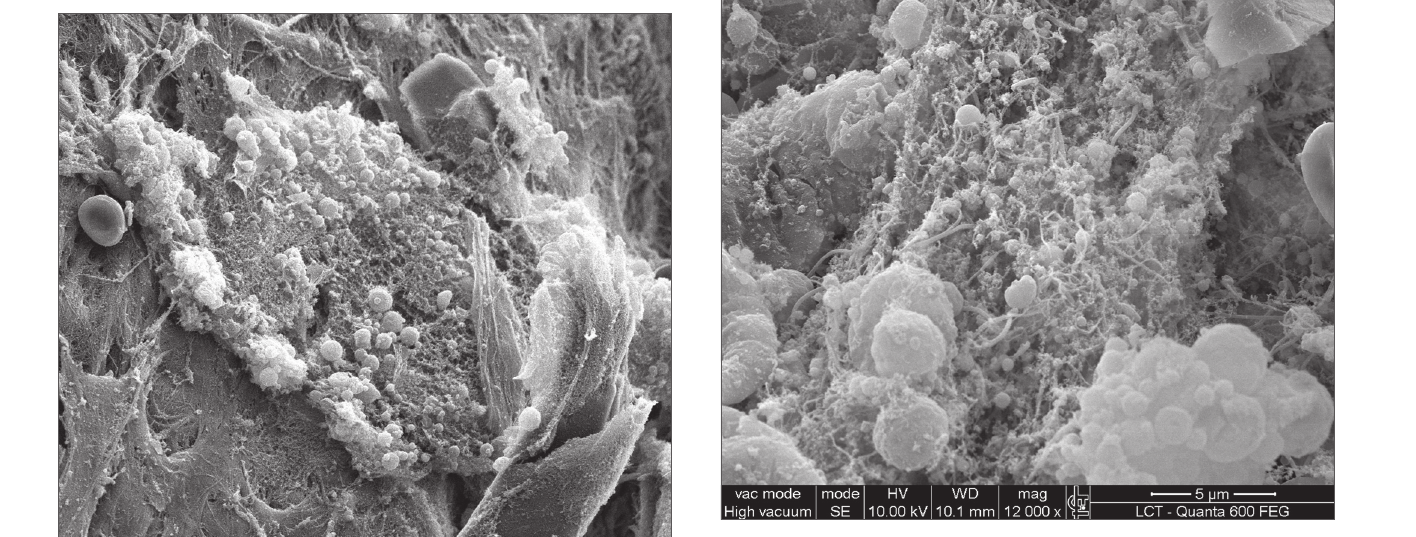
Figura 4. Biofilme bacteriano (12.000x)